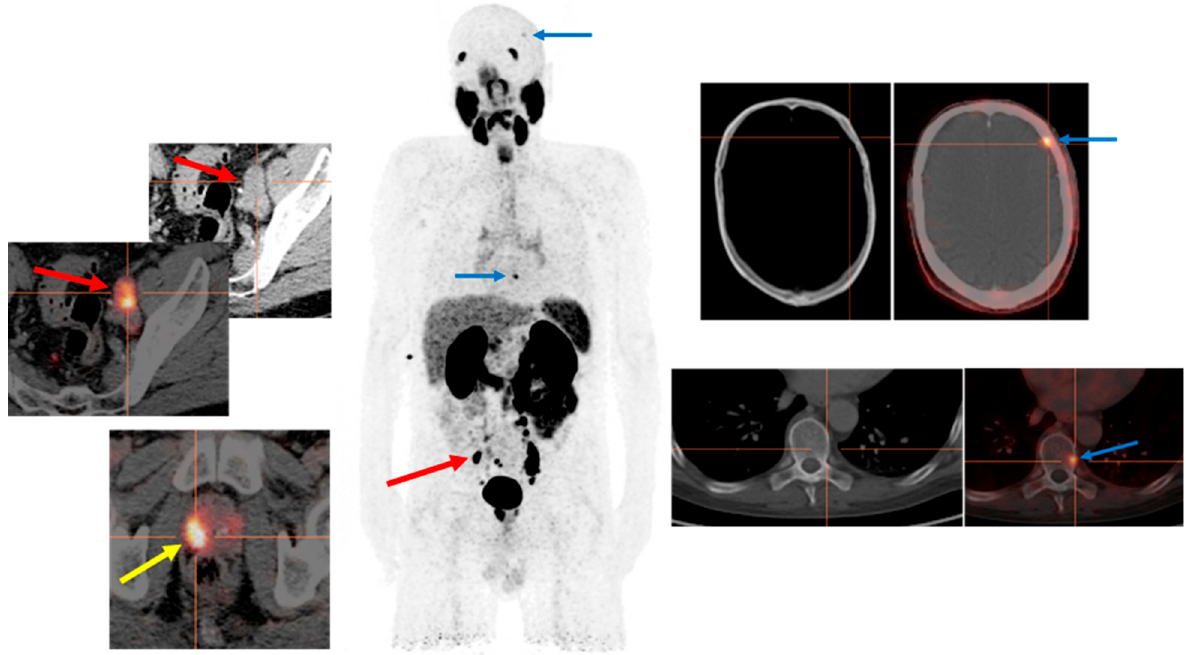
Figure 1. PSMA PET examination for primary staging of a high-risk prostate cancer. PSMA PET-CT Images for primary staging of a 56 year old man, newly diagnosed with PCa: Gleason score (5 + 5) and a PSA value of 45.96 ng/mL showing two PSMA-avid bone lesions frontoparietal in the left side of the skull and the ninth thoracic vertebra (blue arrows) in addition to the primary tumor in the right lobe of the prostate (yellow arrow) and bilateral iliac lymph node metastases (red arrows). Both these bone lesions were not visible on CT examination separately performed for the patient.